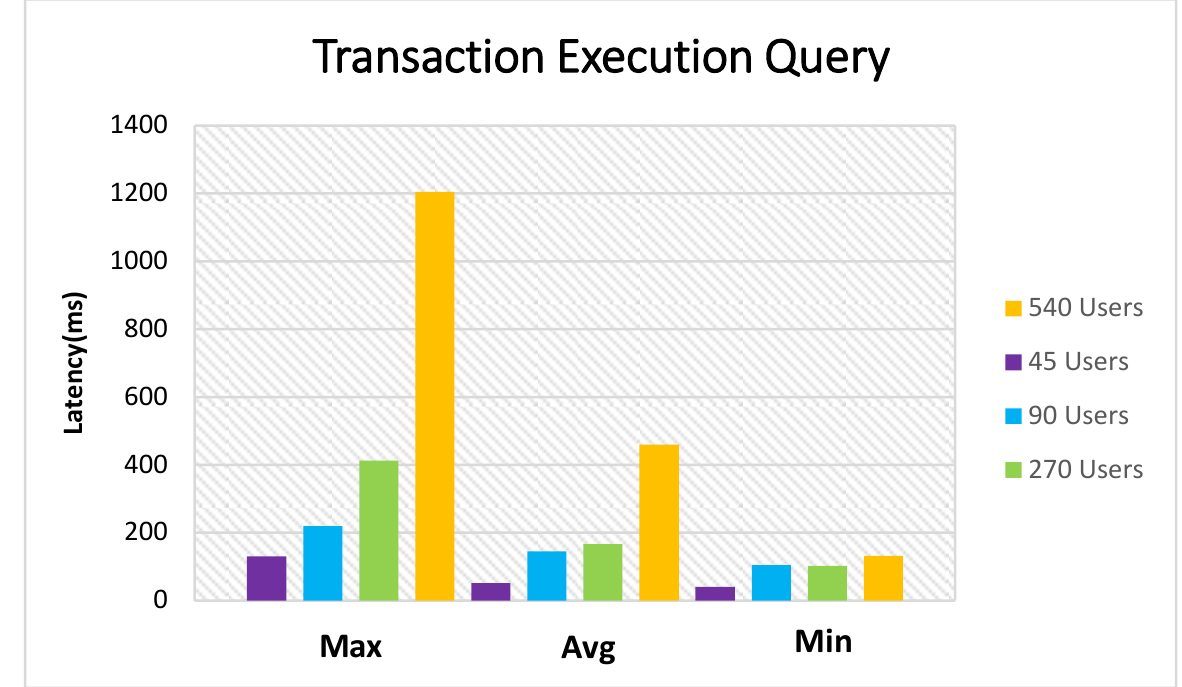
Figure 16. Query transaction latency.